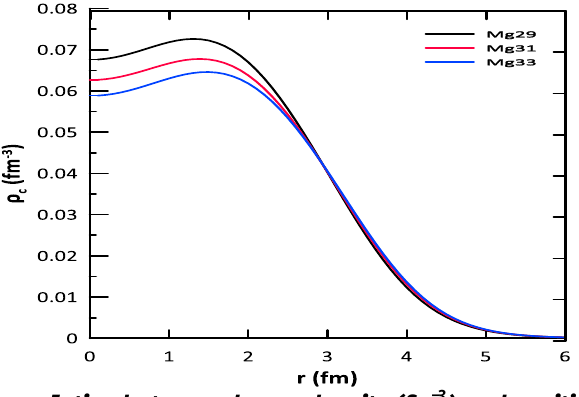
Fig. 4(a): The relation between charge density (fm -3 ) and position r(fm) for 29,31,33 Mg nuclei.